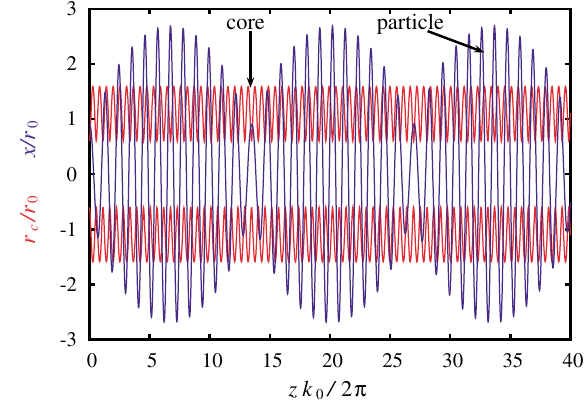
FIG. 1. (Color) Particle and core envelopes for initial mis- match, (cid:16) (cid:3) 0 : 6 , x (cid:4) 0 (cid:5) (cid:3) 0 : 9 r